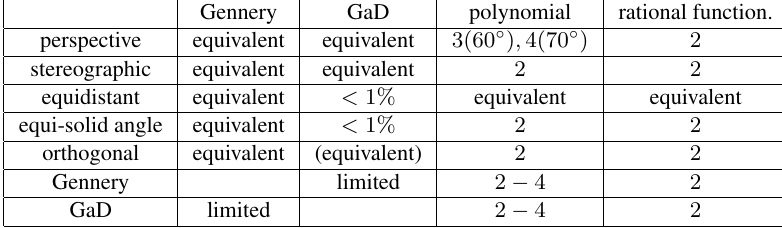
Table 1: Theoretical ability of approximation of camera models (amount of parameters)